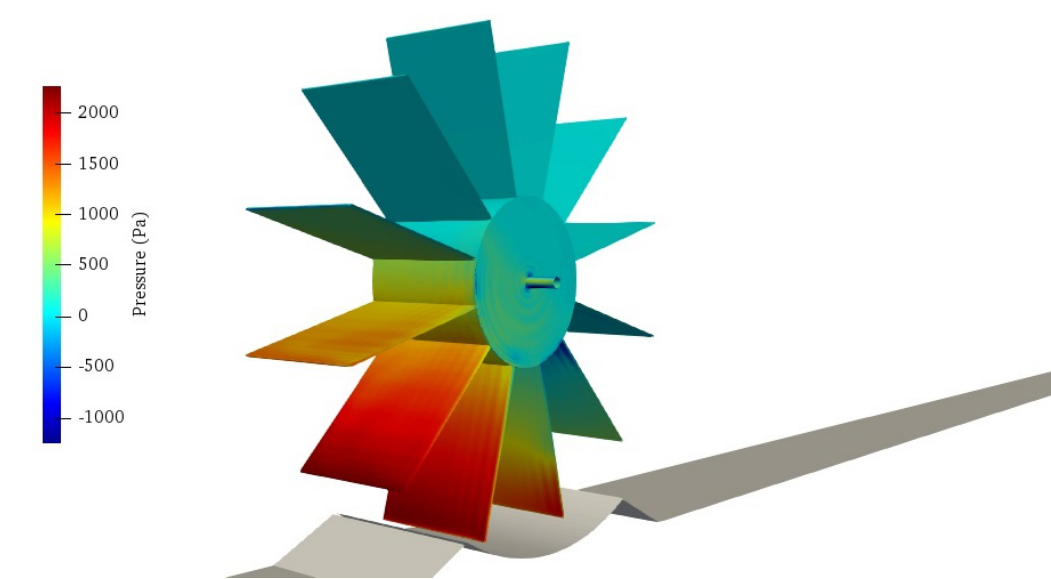
Figure 14. Manometric Pressure acting on the surface of the HPM, at t = 4.0 s.